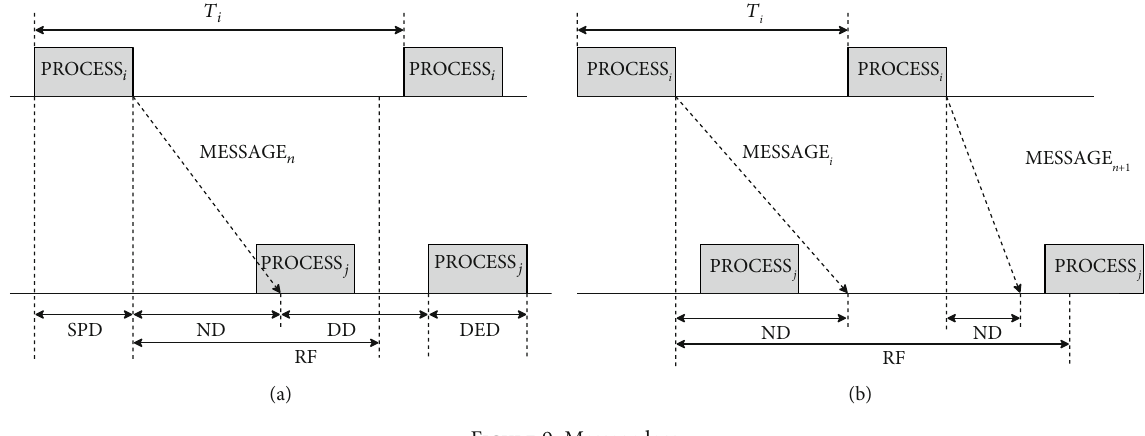
Figure 9: Message